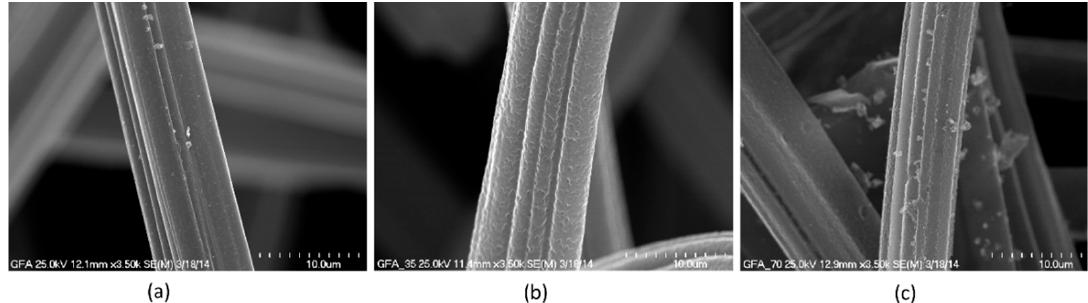
Figure 1. SEM images recorded for GFA ( a ), GFA-35 ( b ), and GFA-70 ( c ) materials.